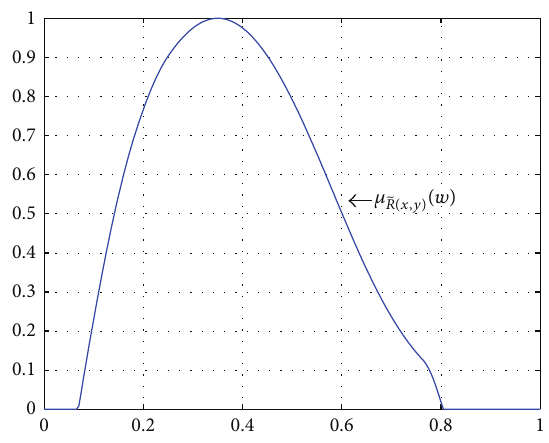
Figure 2: The function graph of 𝜇 ̃𝑅(𝑥,𝑦) (𝑤) in